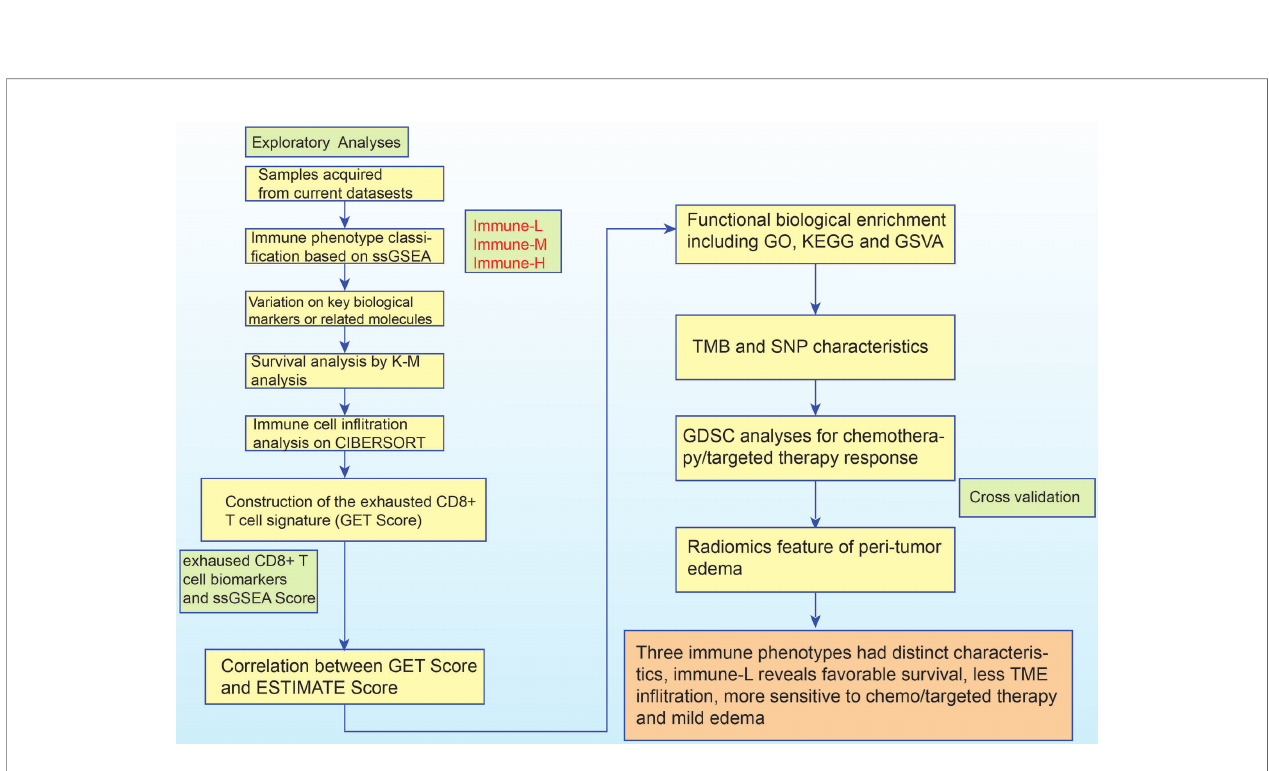
FIGURE 11 | The logic fl ow chart of current